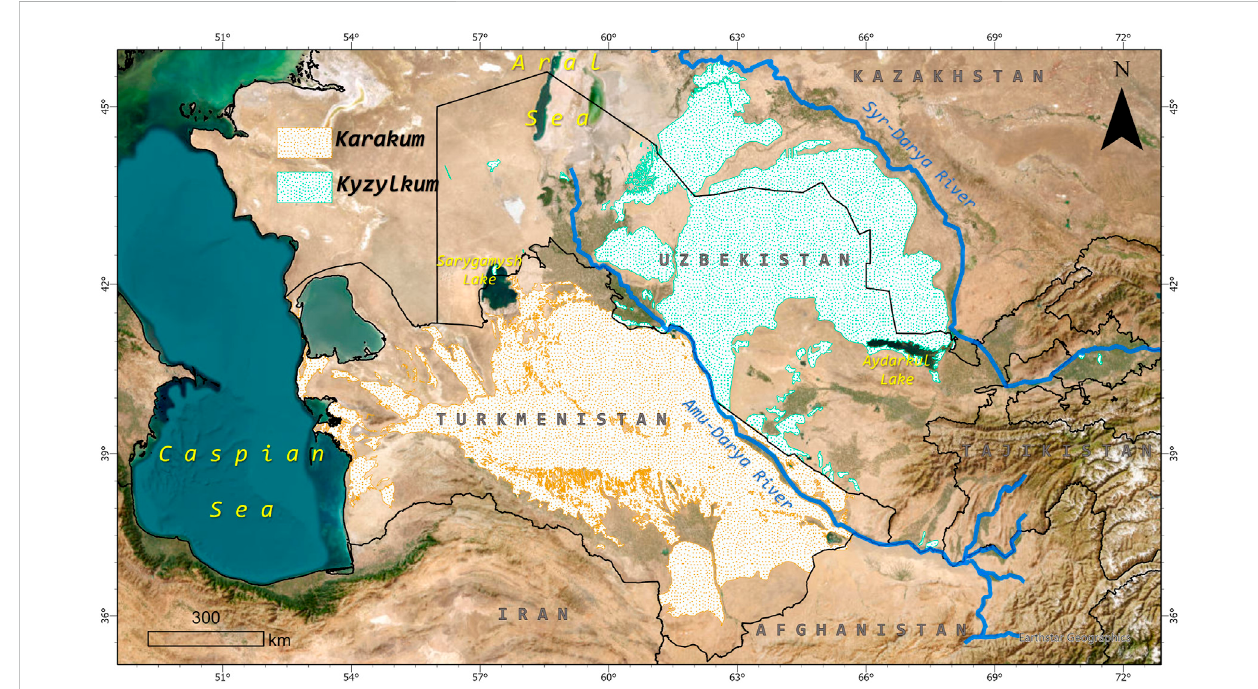
FIGURE 1 Map of the study area: location of Karakum and Kyzylkum Central Asian deserts, adapted from Maman et al. (2011).